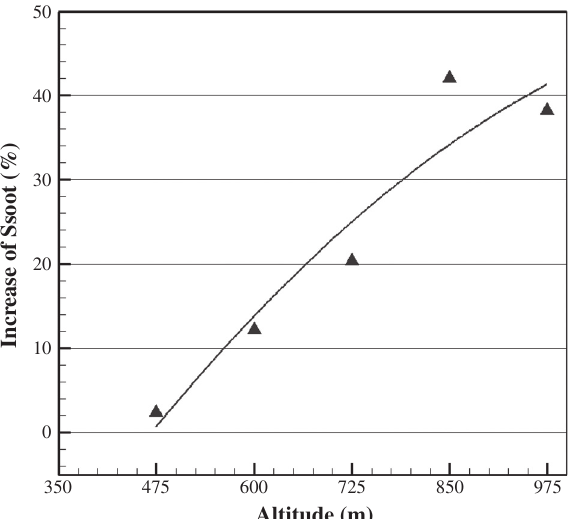
Fig. 8. Percent of increase of brake-specific soot emission with